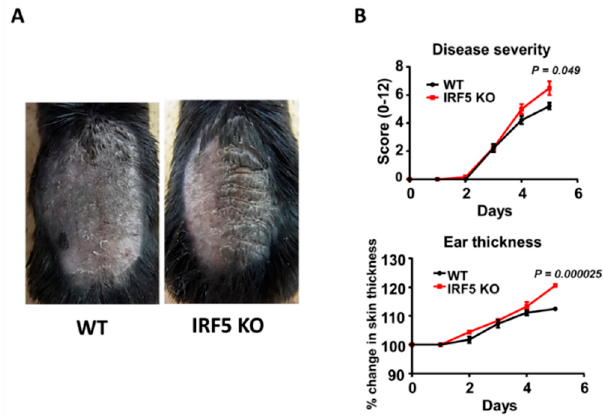
Figure 1. Interferon regulatory factor (IRF)5 deficiency exacerbates psoriasiform dermatitis induced by imiquimod treatment. Shaved back skin and ears of wild-type (WT) and IRF5 knockout (IRF5 KO) mice were topically treated with imiquimod for 5 consecutive days. ( A ) Phenotypical manifestation of WT and IRF5 KO mouse back skin induced by imiquimod application at day 5. Representative